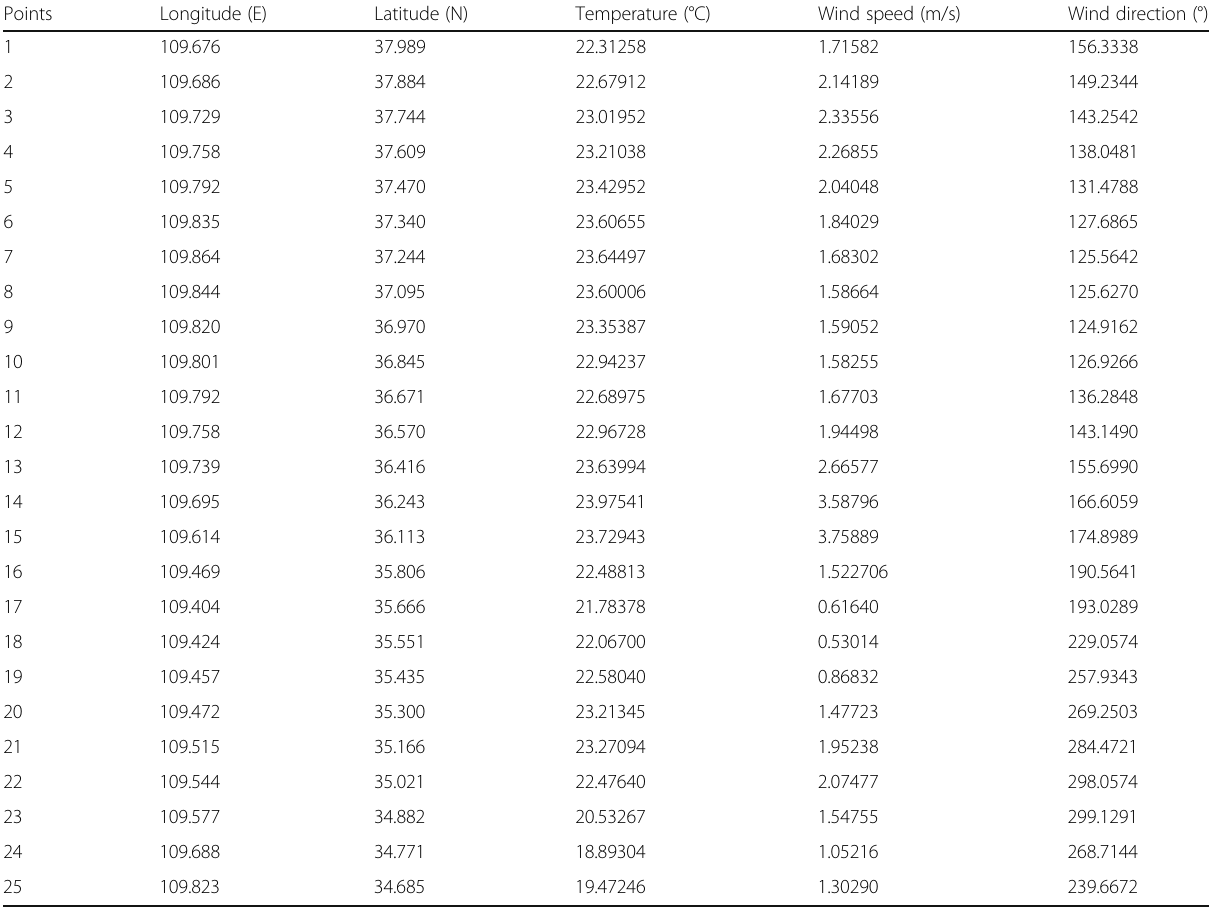
Table 3 Longitude, latitude and environmental parameters of 25 known points